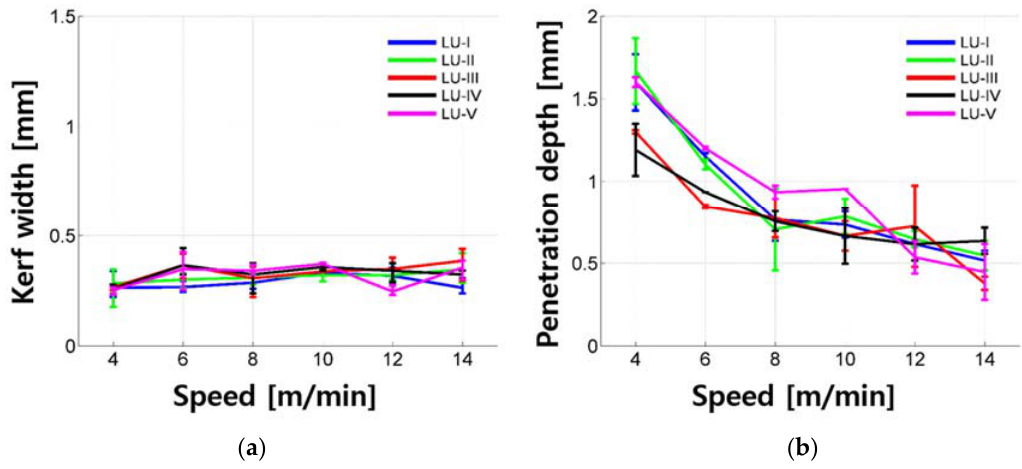
Figure 10. Kerf width ( a ) and penetration depth ( b ) vs. laser moving speed for LU series.